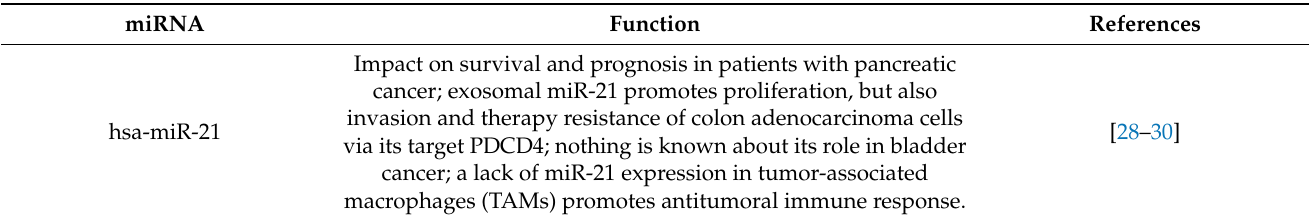
Table 1. The most positively correlated miRNAs and their known functions in human cancers, including bladder cancer, if such a function was